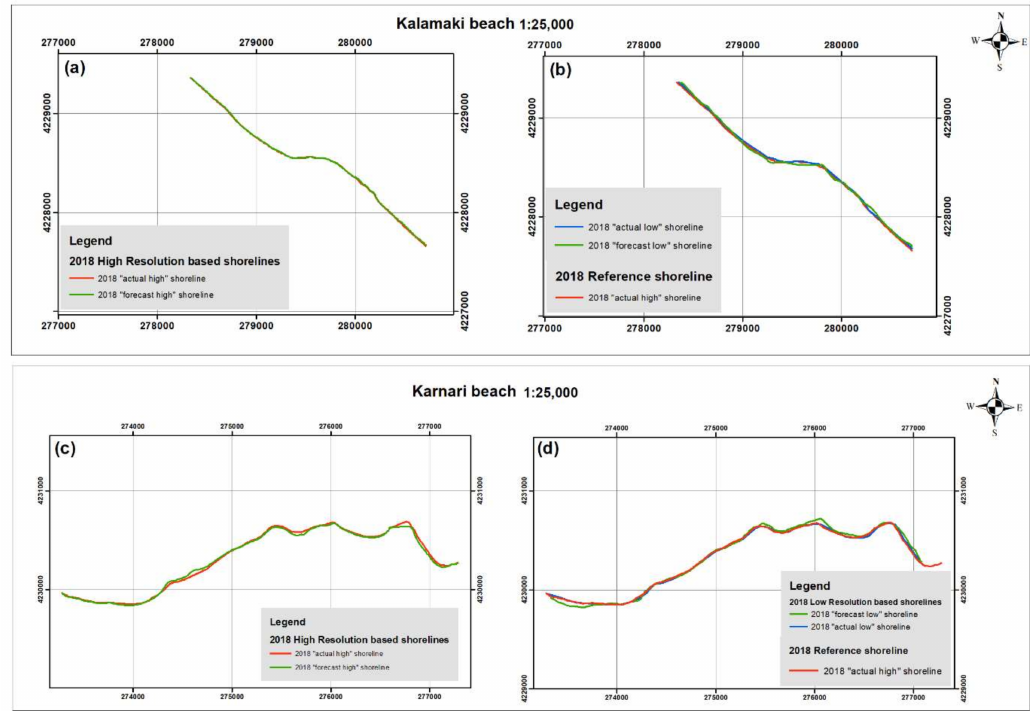
Figure 8. Shorelines of 2018 overlapping at a low scale for ( a ) Kalamaki and ( b ) Karnari beaches, based on both high- ( a , b ) and low-resolution ( c , d ) images.